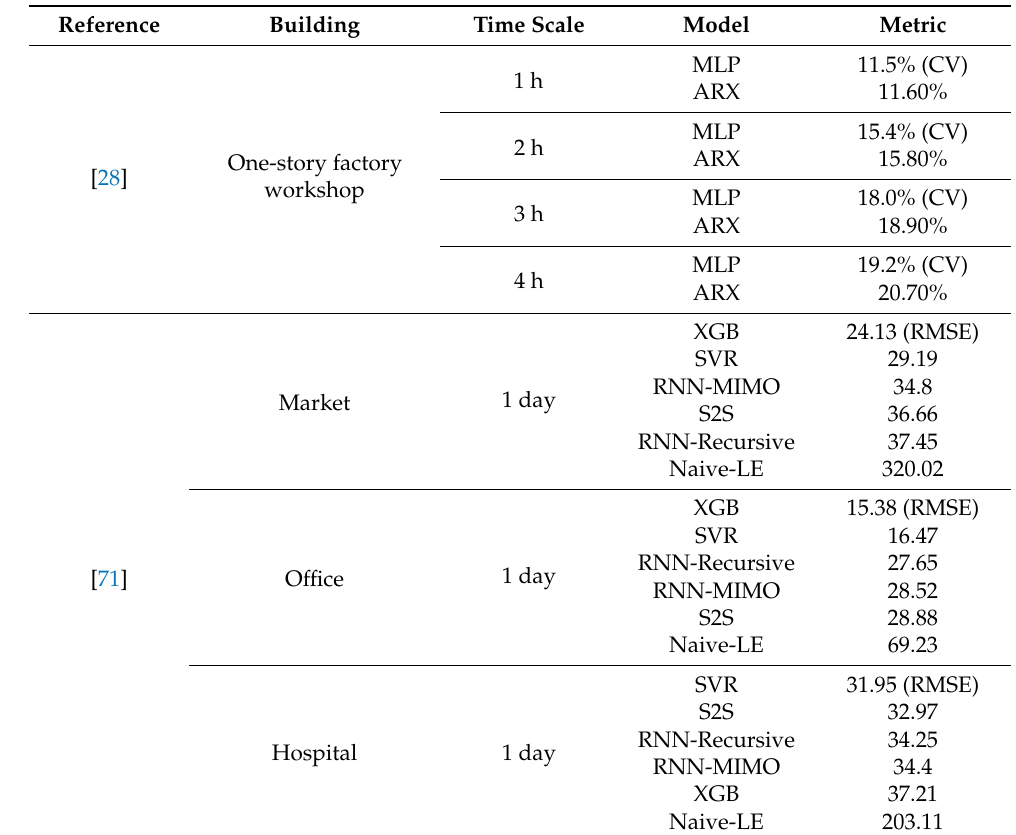
Table 6. Comparative accuracy of different ML